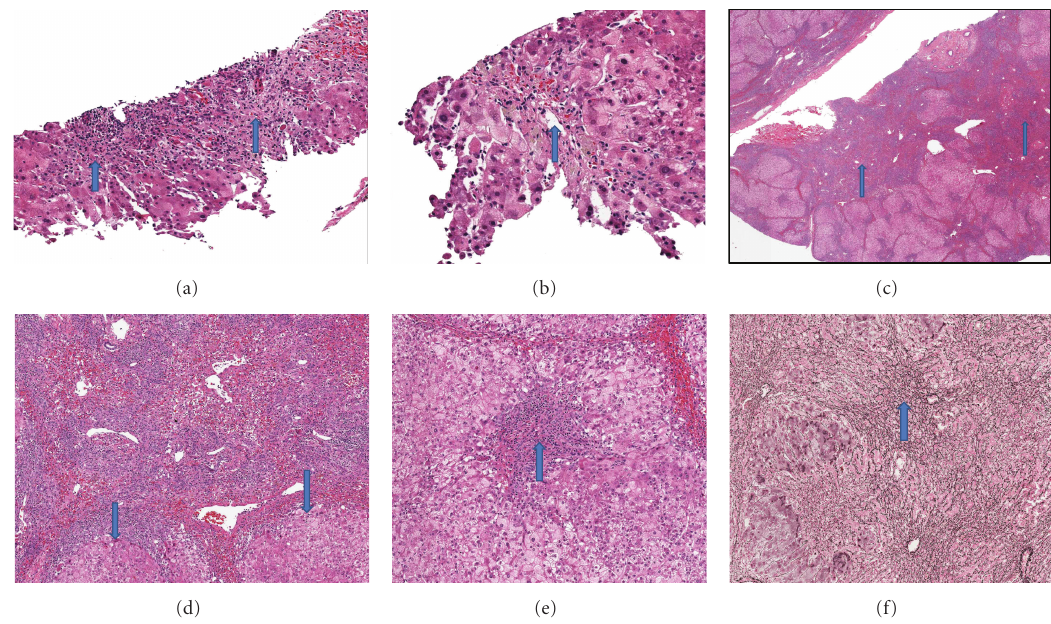
Figure 1: (a) Transjugular biopsy-portal tract showing inflammation with bile ductular proliferation and interface hepatitis (arrows) (H&E 200x). (b) Transjugular biopsy-central vein (arrow) with pericentral hepatocyte dropout, ballooning degeneration, and hemorrhage (H&E 200x). (c) Explant showing architectural collapse (arrows) (H&E 40x). (d) Explant with interface between area of collapse and residual viable parenchyma (arrows) (H&E 100x). (e) Explant with portal/interface hepatitis (arrow). Periportal hepatocytes showing ballooning/cytoplasmic clearing (H&E 100x). (f) Reticulin stain highlights areas of collapse (arrow) adjacent to viable